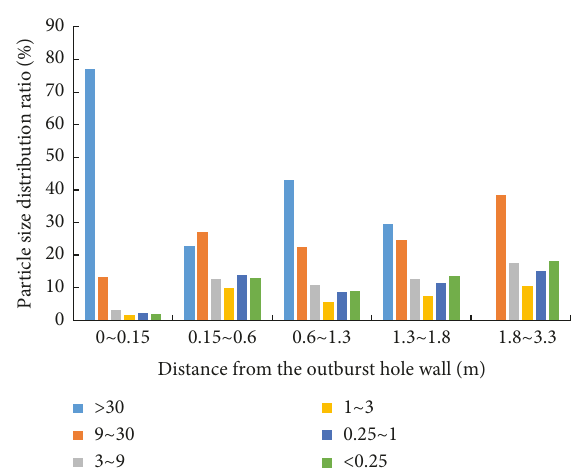
Figure 10: Particle size distribution diagram of thrown coal